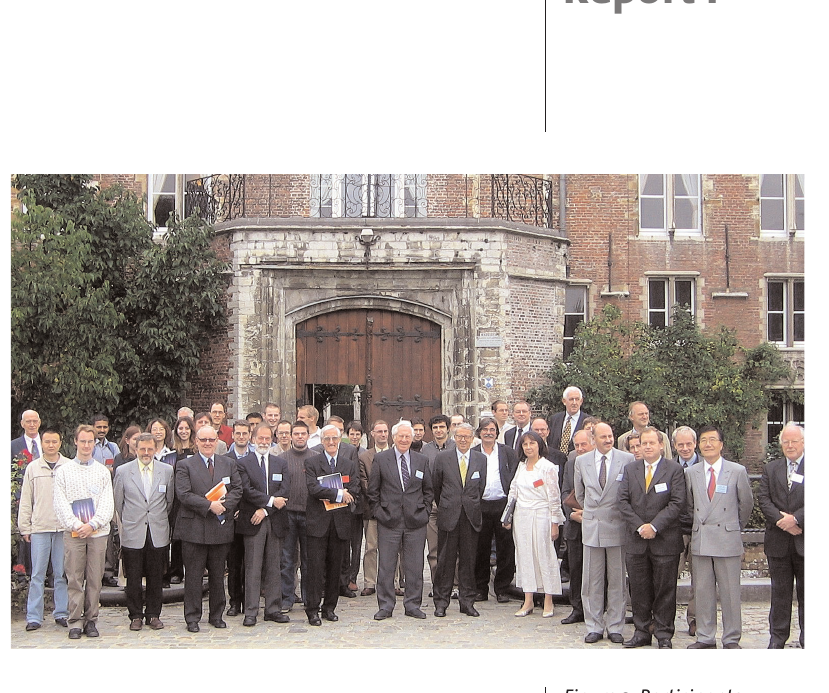
Figure 2: Participants of the symposium in